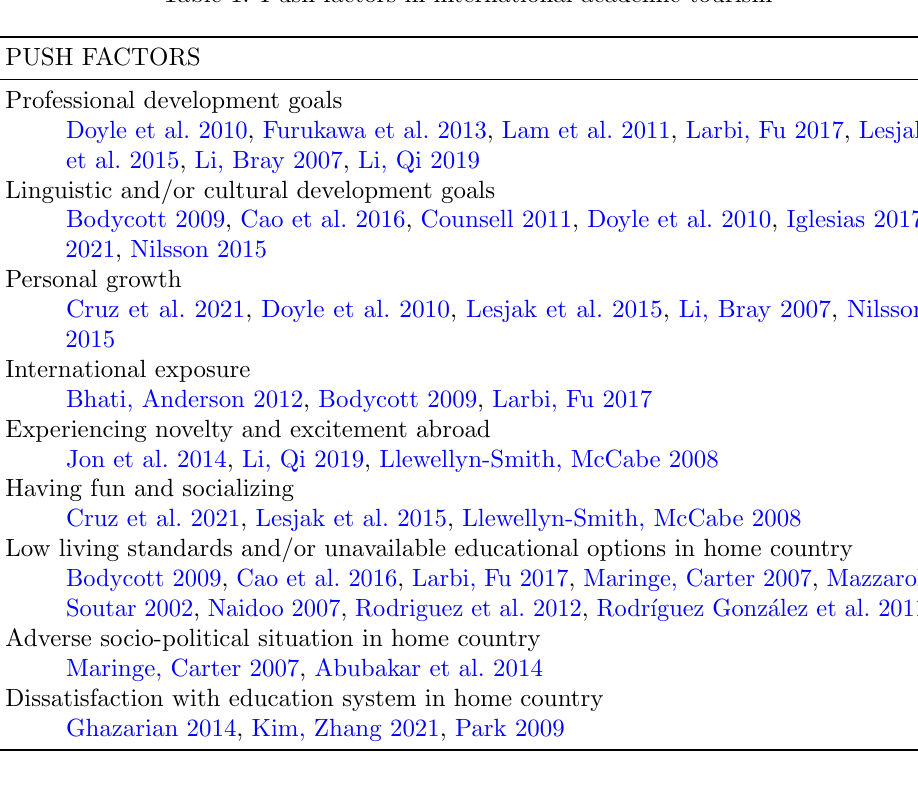
Table 1: Push factors in international academic